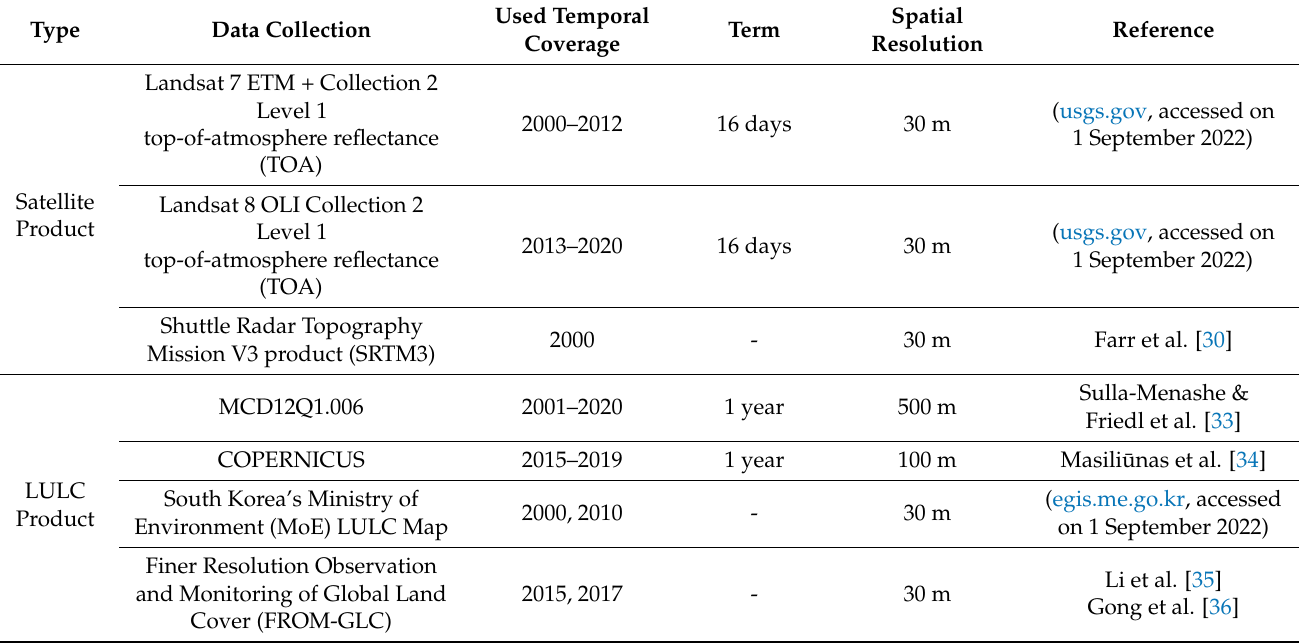
Table 1. Data collection types and information